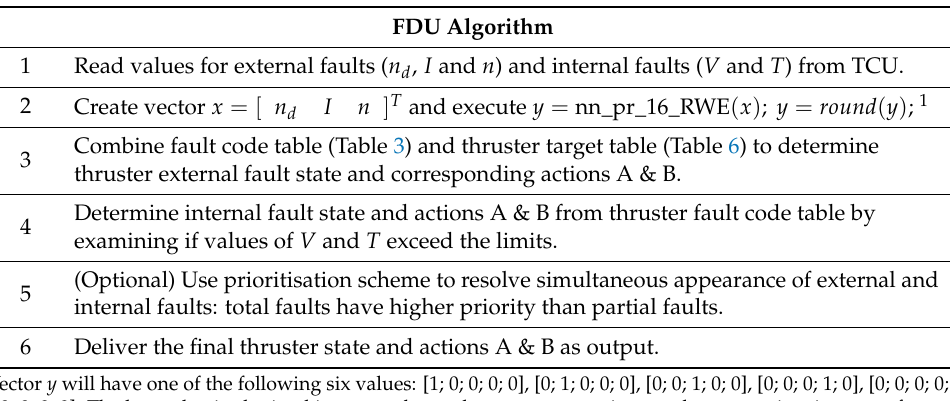
Table 9. FDU Algorithm—On-line fault